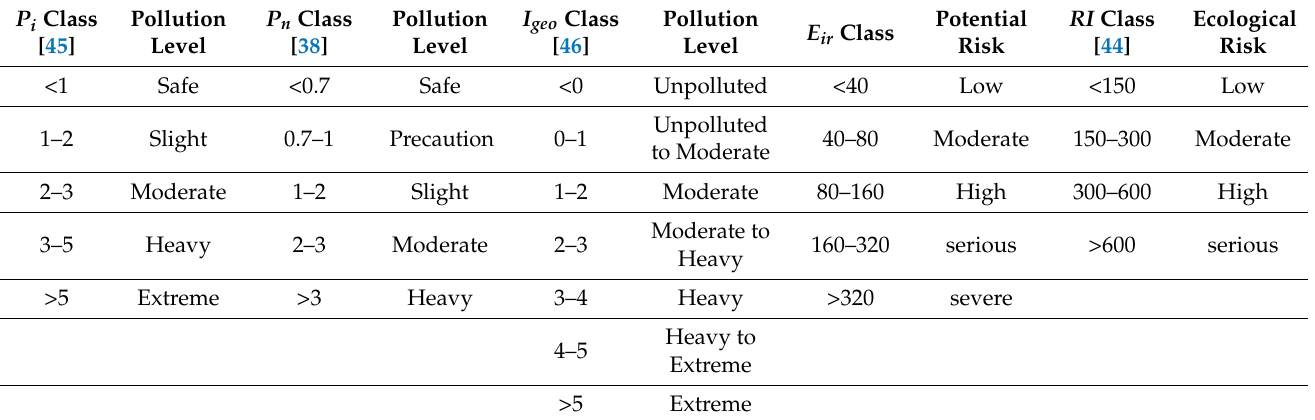
Table 1. Evaluation criteria of pollution indices ( P i and P n ), geo-accumulation index ( I geo ), and risk index ( E ir and RI